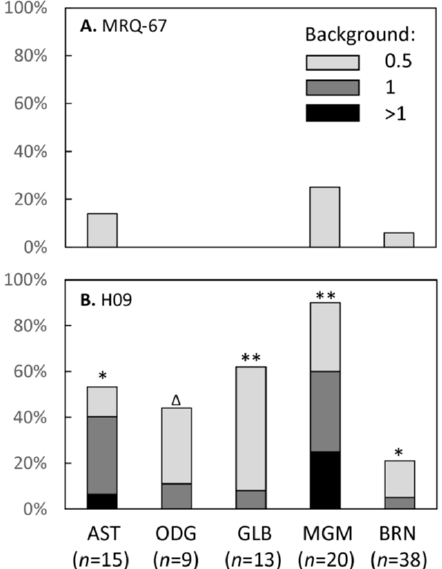
Figure 6. Intensities of background stain for MRQ-67 ( A ) and H09 ( B ) as encountered in astrocytoma (AST), oligodendroglioma (ODG), glioblastoma (GLB), meningioma (MGM), and surrounding non-neoplastic brain samples (BRN), with the statistical results indicated on each bar in B (*, p < 0.05; **, p < 0.01; ∆ , p > 0.05).